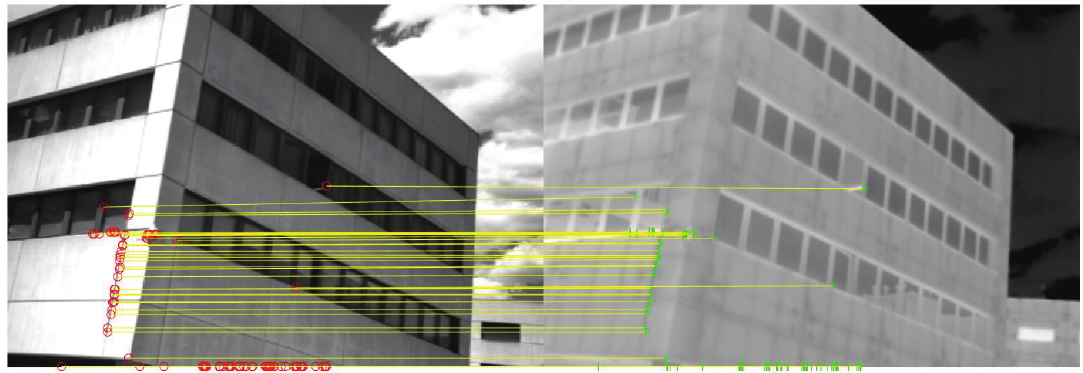
Figure 6. Illustration of corresponding feature point matching in the visible and infrared